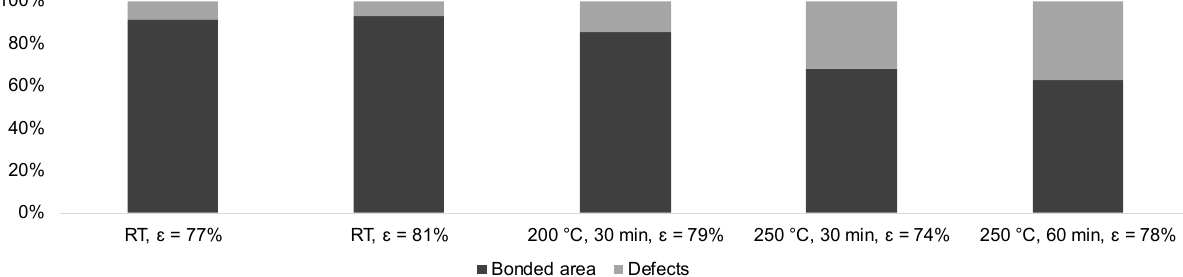
Figure 7. Bond area continuity analysis for different heat treatment parameters and reduction ratios.